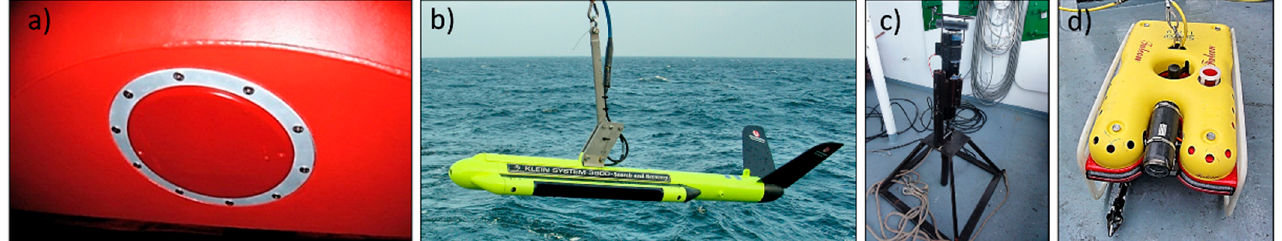
Figure 3. Instruments used for surveying the airplane wreck: ( a ) multibeam echo sounder EM-3002D; ( b ) side-scan sonar Klein 3900 System; ( c ) scanning sonar ver. 1071; ( d ) remotely operated vehicle Falcon SAAB SeaEye.